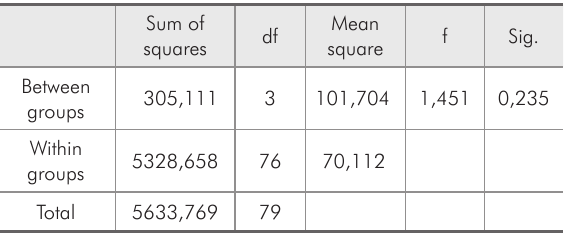
Table 2 - Flexural strength mean ( σ ) and standard deviation (SD) values, Weibull distribution values including the Weibull modulus (m), characteristic strength ( σ ), probability of failure at 0 5% ( σ ) and at 1% ( σ ) and 0.05 0.01 correlation coefficient (CC) for all experimental groups. The failure mode distribution (number of specimens per group) for each group is also shown. Table 3 - One-way ANOVA test for flexural strength values